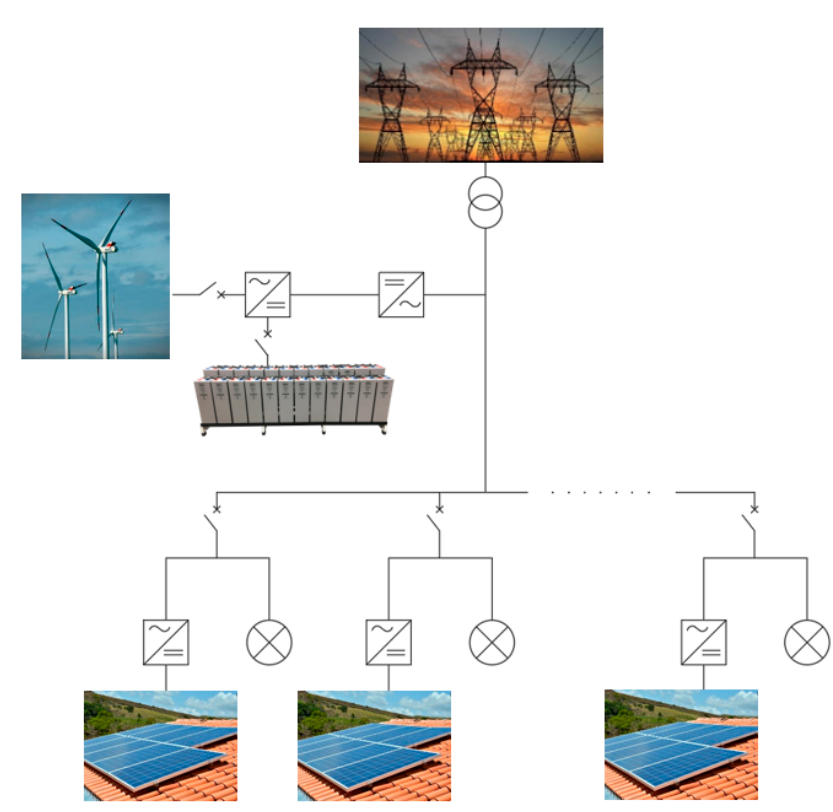
Figure 2. Schematized representation of the microgrid configuration. Source: self-elaboration. Images under a CC BY-SA license.